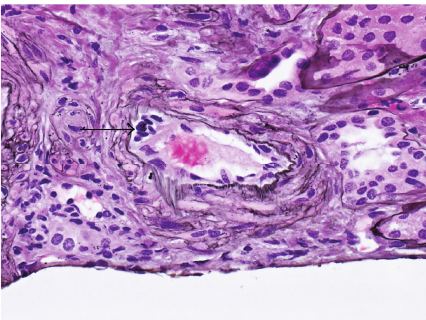
Figure 1: An interlobular artery shows a small collection of lym- phocytes beneath the vascular endothelium, sufficient for v1 lesion according to Banff criteria (thick arrow). Jones 400x